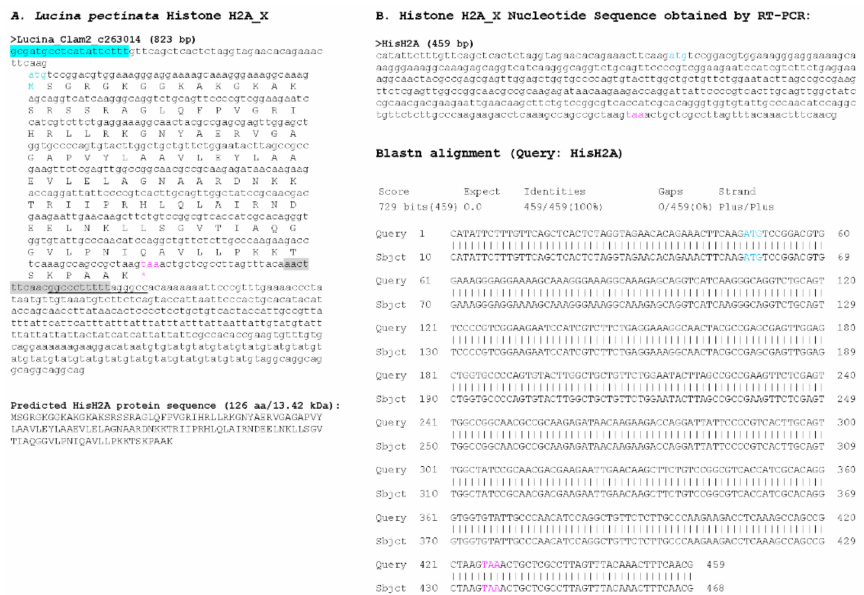
Figure 5. Histone H2A_X sequence found in Lucina pectinata genome assembly. ( A ) One of the four H2A-like nucleotide sequence obtained from the BLASTN searches against the L. pectinata genome assembly using the H2A nucleotide sequence from S. marginatus is shown, including the coding region, the predicted protein sequence and its molecular weight (MW). Primers used in RT-PCR are highlighted in cyan and grey. Start (cyan) and stop (pink) codons are indicated. ( B ) The nucleotide sequence obtained by Sanger sequencing of RT-PCR products followed by the BLASTN alignment of the cDNA to the genomic sequence, showing a perfect match between the two sequences.